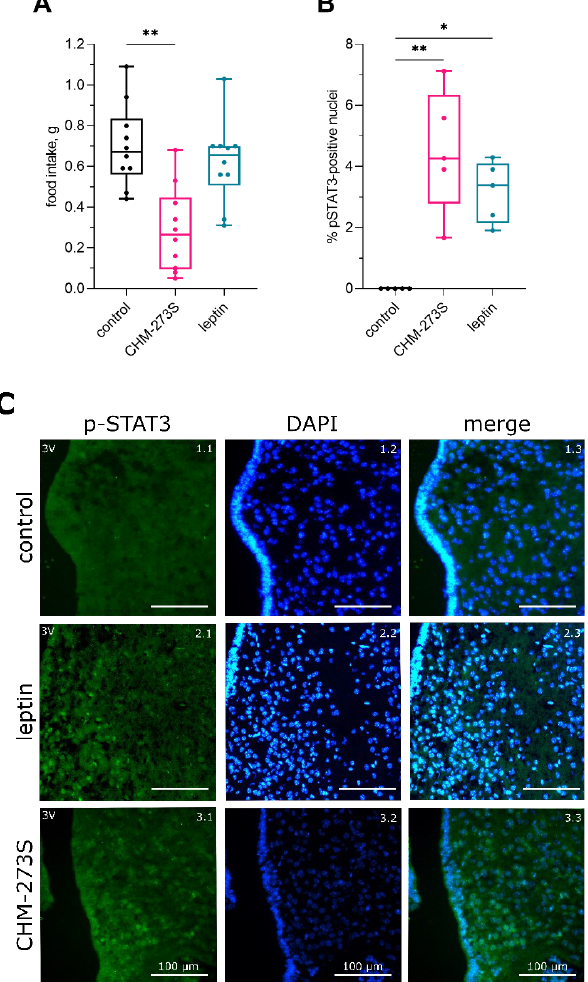
Figure 2. The effects of CHM-273S on food intake and p-STAT3 in the hypothalamus of naïve mice. ( A ) CHM-273S (5 mg/kg intranasally, i.n.) but not leptin (1 mg/kg intraperitoneally, i.p.) signifi- cantly reduced 90 min home cage food consumption (H (3, 30) = 13.52, p = 0.0012). ( B ) CHM-273S (10 mg/kg i.n.) significantly induced STAT3 phosphorylation in the hypothalamus, similarly to leptin (5 mg/kg i.p.) (H (3, 15) = 10.35, p = 0.0007). The results are presented as box and whisker plots with